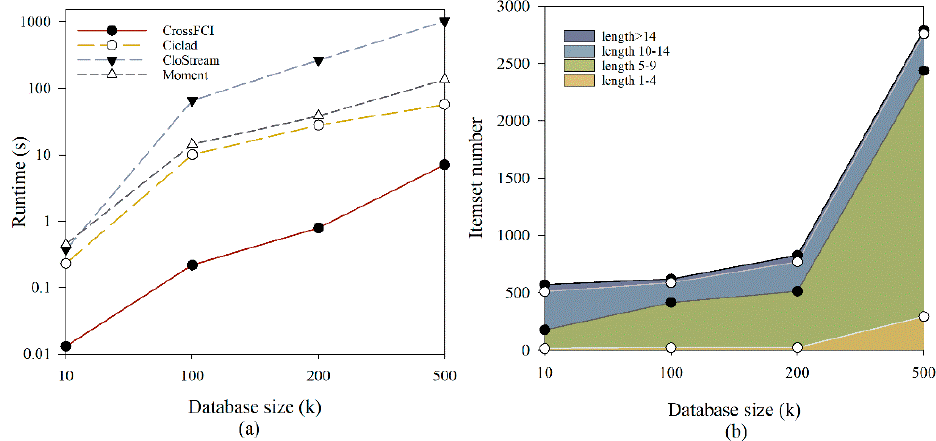
Figure 9. Scalability comparison of different FCIM algorithms. ( a ) Runtime comparison of different FCIM algorithms. ( b ) Itemset number of different FCI lengths.